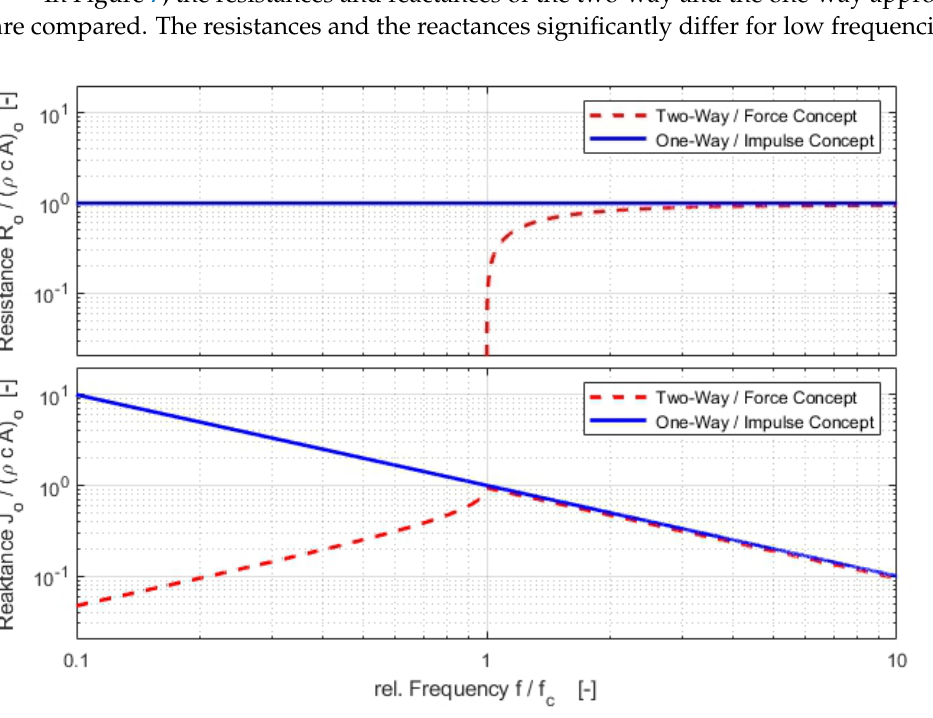
Figure 7. For the semi-infinite exponential horn with the contour A = A o exp ( − α x ) the two-way based “force concept” predicts no resistance below the cut-off frequency f c = α c /4 π , for frequencies f > f c , there is asymptotic approximation towards R o = ( ρ cA ) o . In contrast, according to the one-way based “impulse concept” a constant resistance R o = ( ρ cA ) o exists over the entire frequency range. For the semi-infinite exponential horn both concepts have the same reactance; however, for frequencies f < f c the values differ